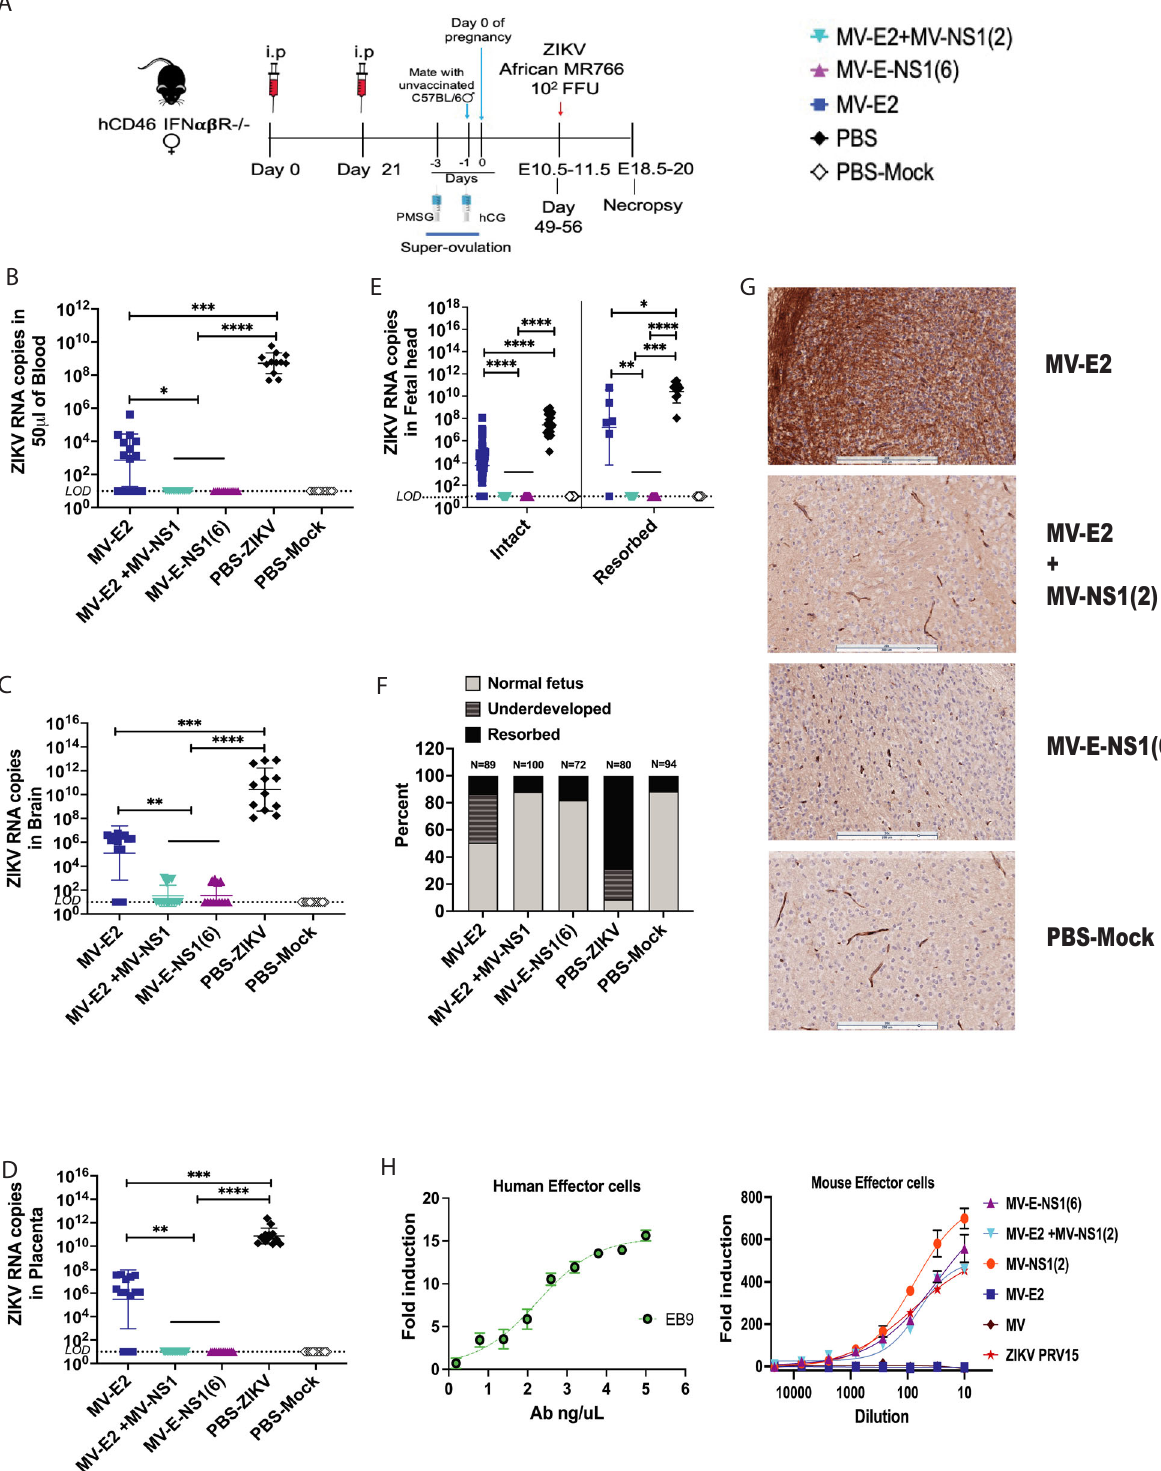
adverse fetal outcomes in pregnant monkeys under prolonged ZIKV exposure 22 . Failure of the Zika puri fi ed inactivated virus (ZPIV) to induce durable responses in human phase I clinical trials beyond 16 weeks suggested that further development in ZIKV vaccine strategies is paramount for protecting susceptible pregnant women and their unborn fetuses 32 . We tested the